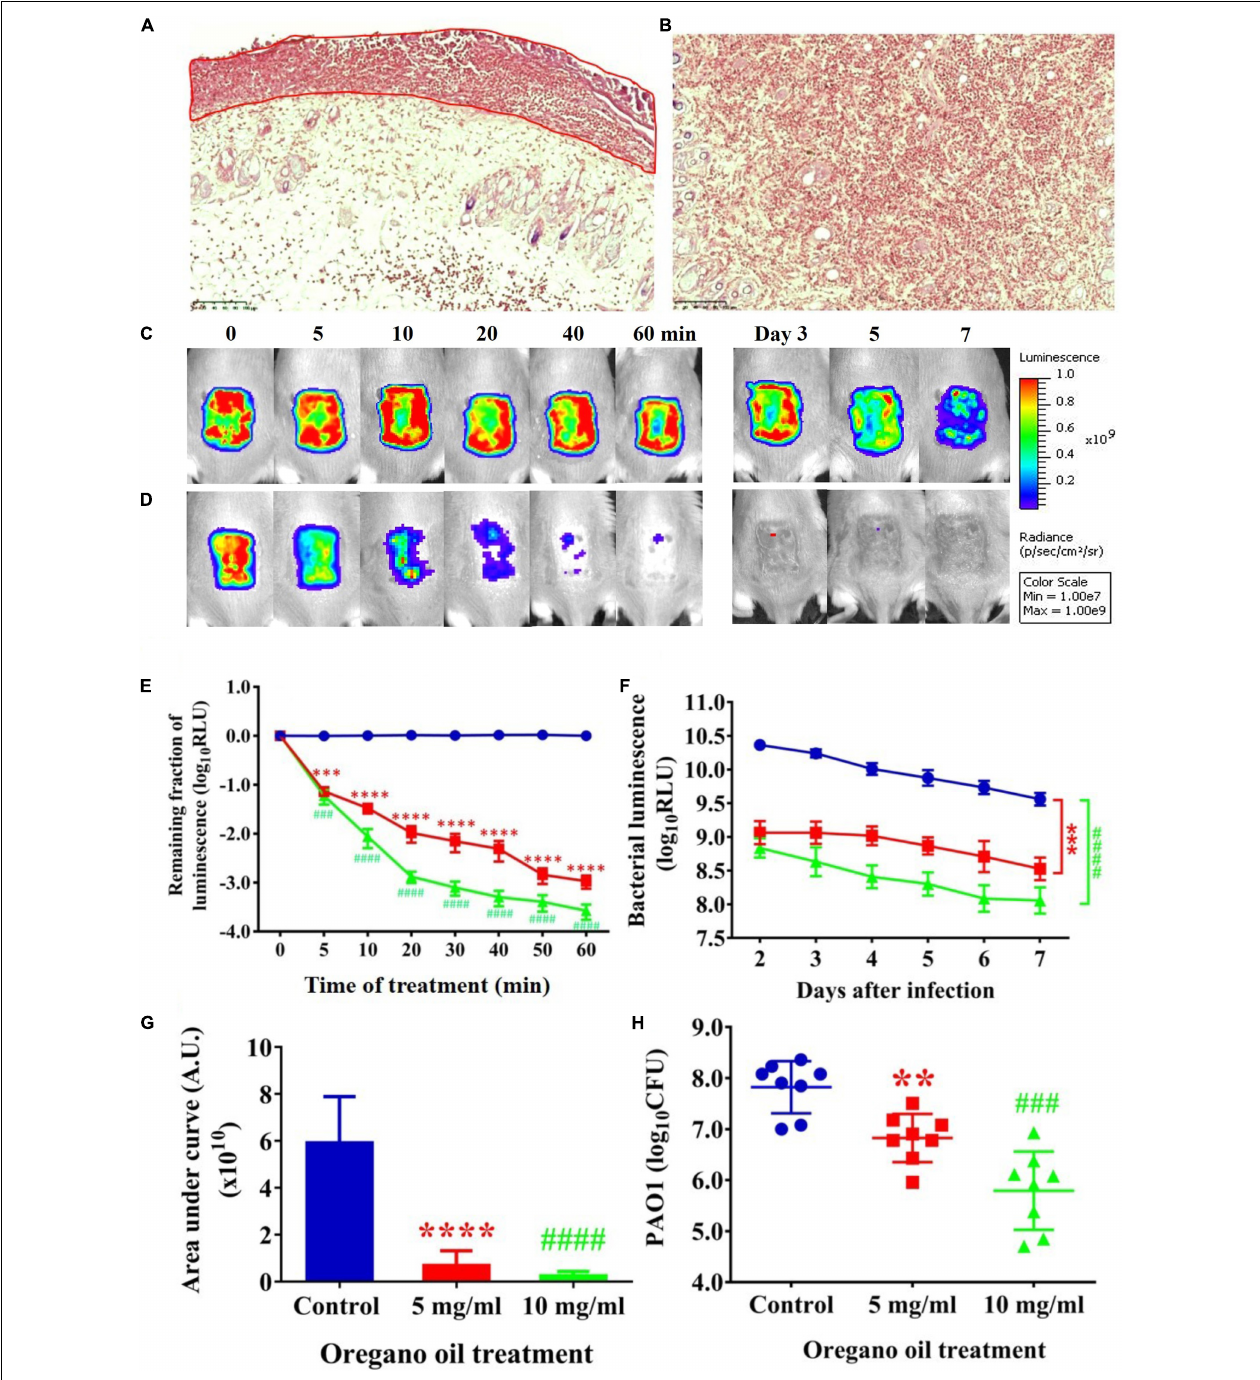
FIGURE 4 | Oregano oil treatment of PA01 infections in the burn wounds. (A,B) Gram-stained longitudinal section (A) and crossing section (B) of a representative wound showing the presence of PA01 biofilms outlined in red. The skin sample was harvested 24 h after bacterial inoculation. (C,D) Successive bacterial luminescence images of representative wounds infected with 5 × 10 6 CFU of luminescent PA01 with (D) and without (C) oregano oil at 10 mg/ml. The oregano oil was topically applied onto the wounds at 24 h after bacterial inoculation. (E) A dose response of mean bacterial luminescence of the wounds infected with 5 × 10 6 CFU of PA01 in the presence or absence of oregano oil treatment at 5 or 10 mg/ml. (F) Time courses of mean bacterial luminescence of the infected wounds in the presence or absence of oregano oil treatment at 5 or 10 mg/ml from days 2 to 7. (G) Mean areas under the bacterial luminescence curves (F) , representing the overall bacterial burden of infected wounds. (H) . The wounds were treated with grape seed oil (control) or oregano oil 24 h after infection and bacterial CFU were quantified on day 7 after bacterial inoculation. RLU, relative luminescence units; A.U., arbitrary units. The data represent means ± SDs ( n = 8). ∗∗ p < 0.01, ### or ∗∗∗ p < 0.001 and #### or ∗∗∗∗ p < 0.0001 in the presence vs. absence of oregano oil. ns, no significance.